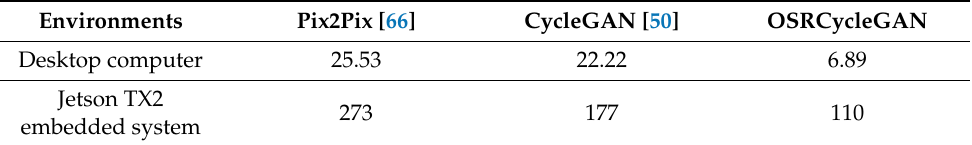
Table 13. Average processing time of one image by Pix2Pix, original CycleGAN, and proposed OSRCycleGAN (unit: ms).